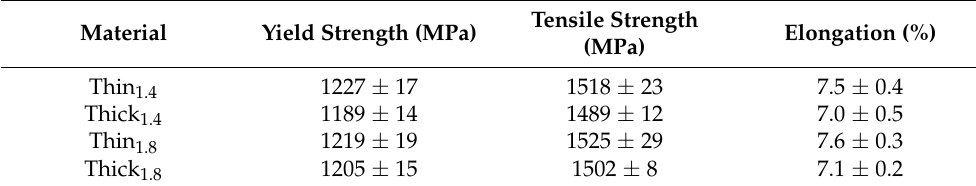
Table 2. Tensile properties of the Al–Si-coated steels after press-hardening.